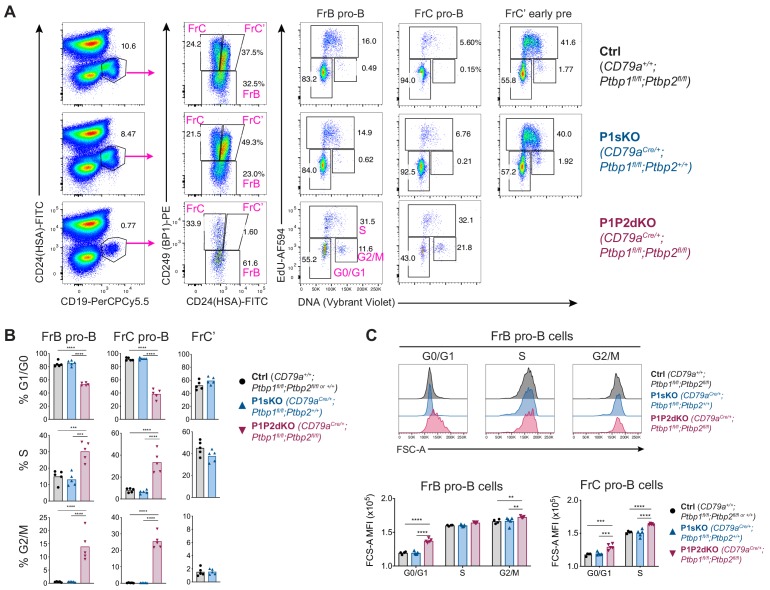
Cell cycle analysis in FrB and FrC pro-B cells.(A) Identification strategy of proliferating FrB and FrC pro-B cells amongst bone marrow cells from mice with the indicated genotypes. Events shown on the left were pre-gated on eFluor780- live IgM-, IgD-, CD2-, CD25-, Gr1- bone marrow cells. Mice were injected with EdU i.p. one hour before analysis to track cells in G0/G1, S and G2/M phases of the cell cycle. (B) Proportions of FrB and FrC developing B cells in G0/G1, S and G2/M phases identified as as in A. Data shown are from one out of three independent experiments. (C) FCS-A measurements of FrB and FrC pro-B cells in different phases of the cell cycle identified as in A. No data are shown for FrC pro-B cells in G2 as there were too few events to carry out reliable measurements. (B, C) Bars depict arithmetic means, each point represents data from an individual mouse and P-values were calculated by one-way ANOVA with Tukey's multiple comparisons test. Summary adjusted p-value *<0.05, **<0.01, ***<0.001, ****<0.0001.